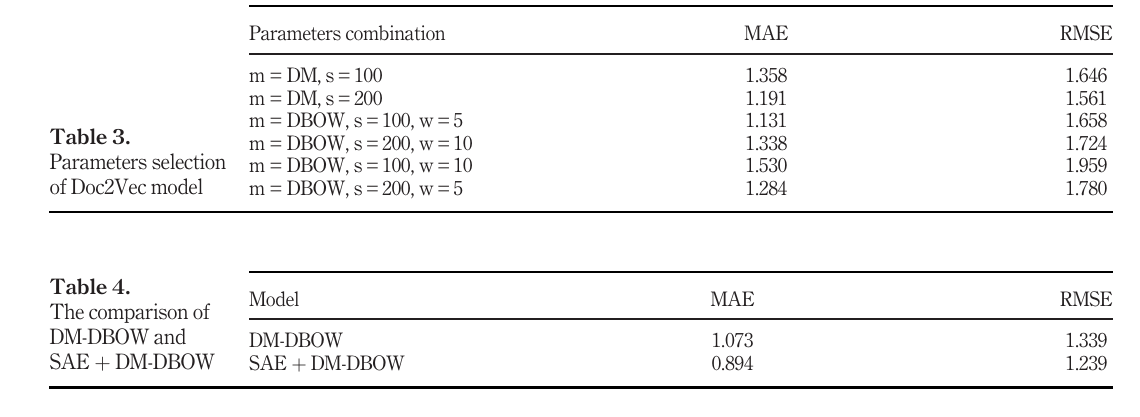
Parameters combination